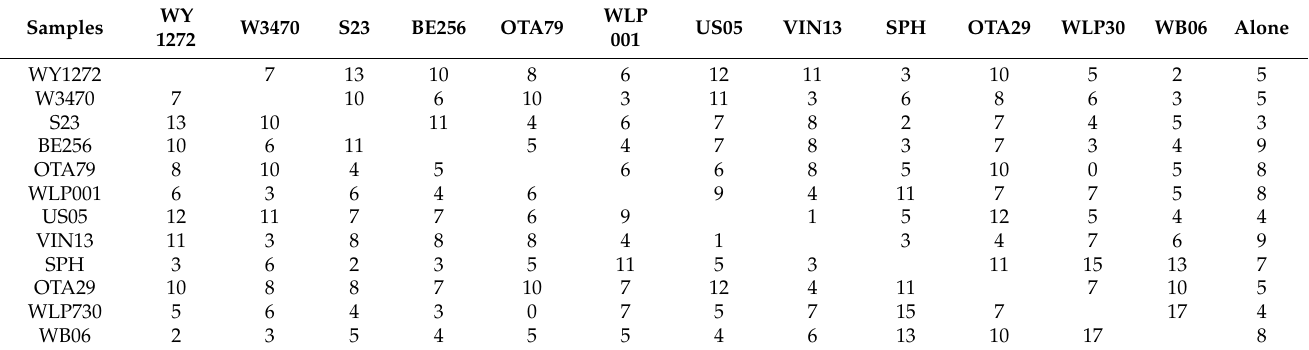
Table 3. Co-occurrences of beer samples in the sorting